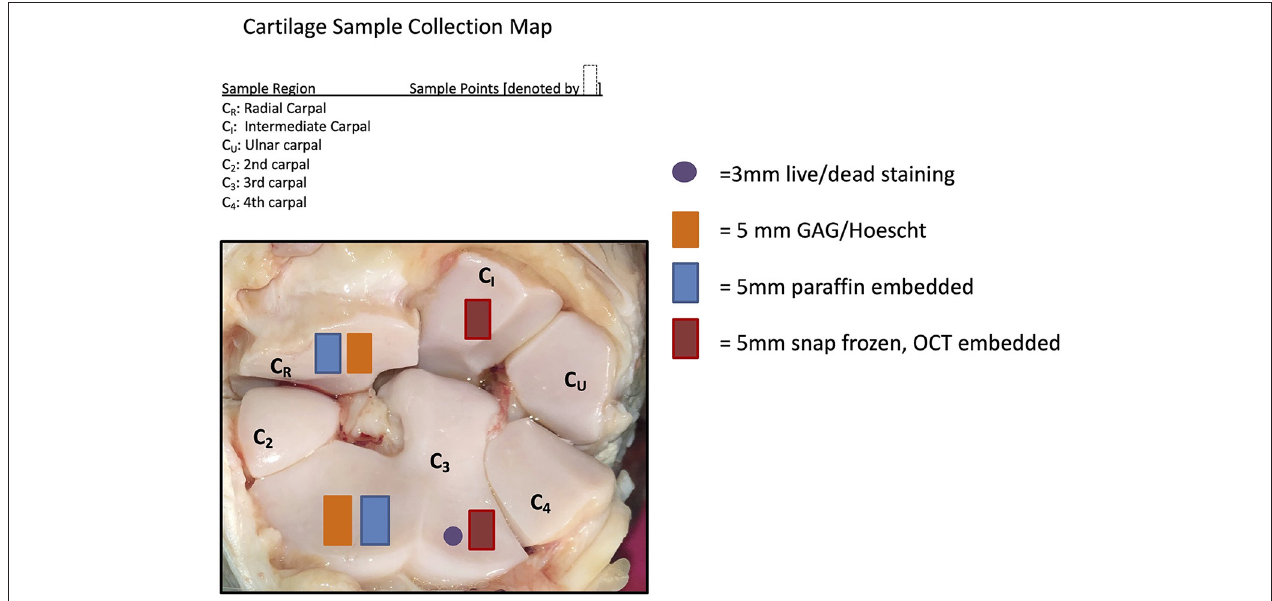
FIGURE 1 | Cartilage sample collection map demonstrating where the samples were collected for the post-mortem sampling.